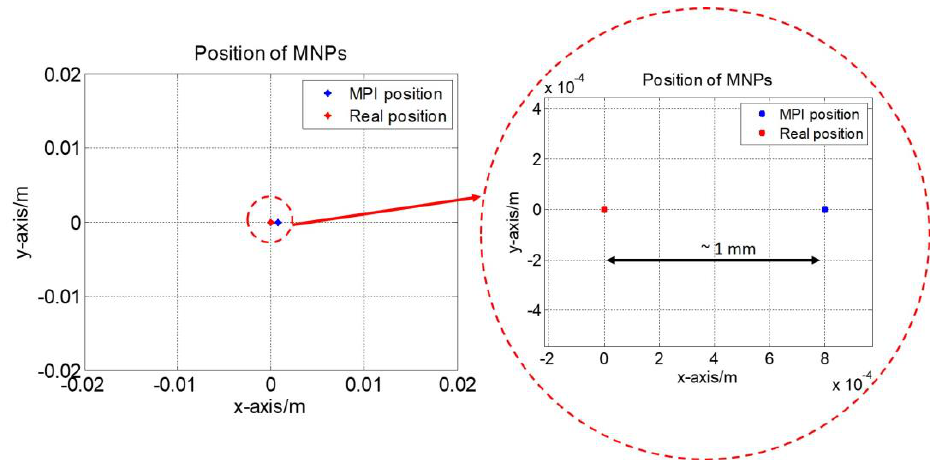
Figure 5. Two-dimensional amplitude-modulation (AM) MPI signal results for MNPs at the center of